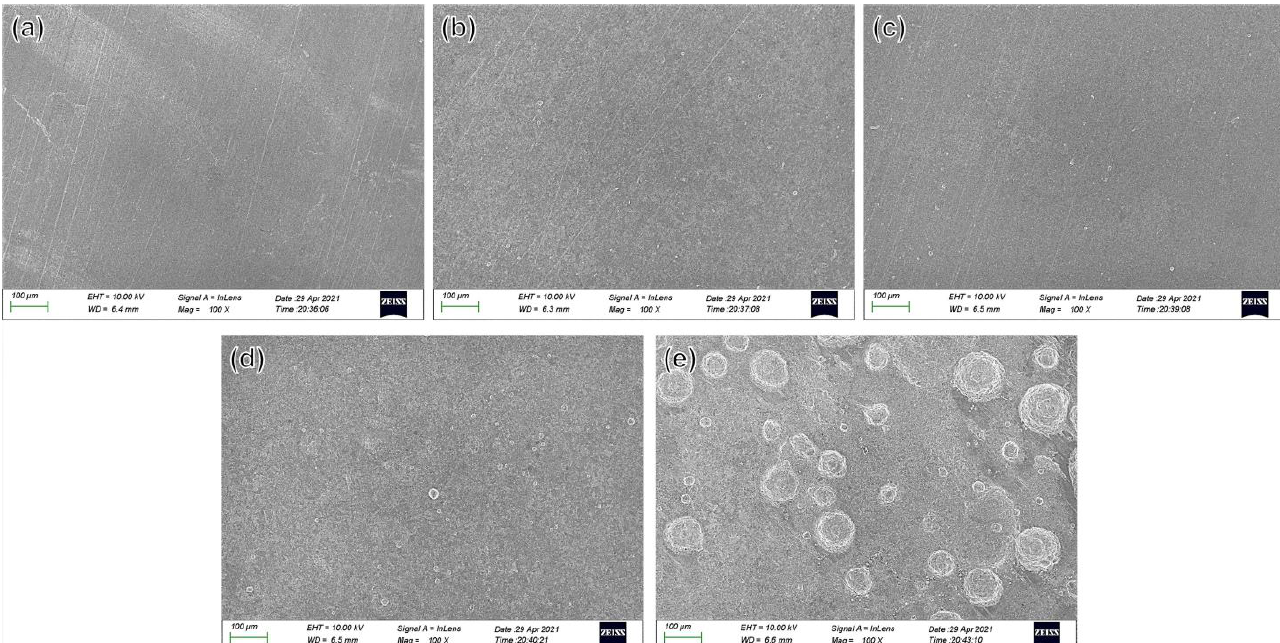
Figure 12. SEM images of the corrosion morphology of X80 steel samples after 2 h in NS4 solution under various DC densities without applied strain: ( a ) i DC = 0 mA/cm 2 , ( b ) i DC = 0.25 mA/cm 2 , ( c ) i DC = 0.5 mA/cm 2 , ( d ) i DC = 1 mA/cm 2 , I i DC = 2 mA/cm 2 .